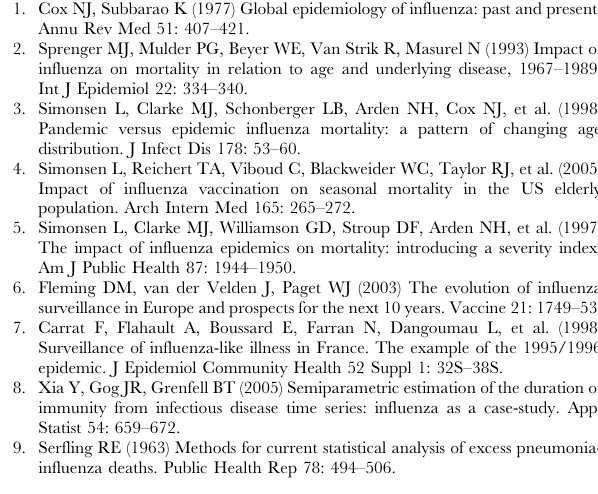
Figure S1 Weekly observed and predicted excess P&I mortality in persons over 65 years. P&I: pneumonia and